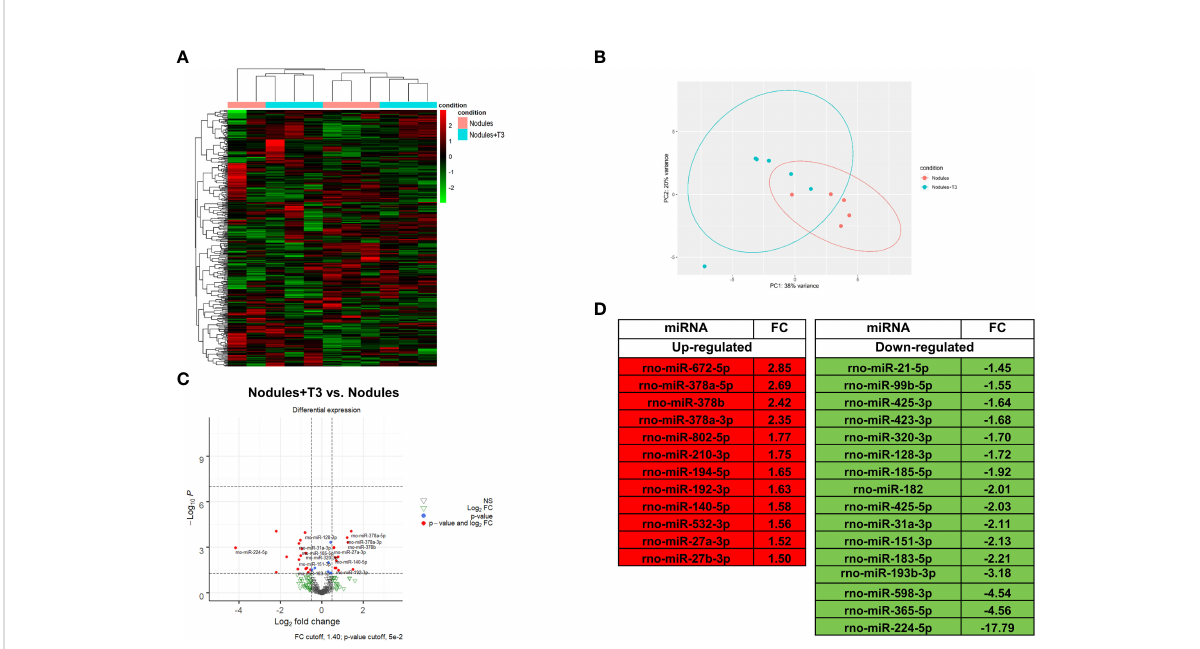
FIGURE 3 T3 modi fi es the global miRNA expression pro fi le of preneoplastic lesions (A) Hierarchical clustering of miRNA in preneoplastic lesions untreated (nodules) or treated with T3 for 4 days (nodules +T3). Each row represents the expression of a gene and each column a sample. Red and green colors represent higher or lower miRNA expression levels (median-centered), respectively; (B) Principal component analysis (PCA) indicative of the variability of miRNA expression data in nodules untreated or treated with T3 for 4 days; (C) Volcano plot of the 28 signi fi cantly differentially expressed miRNAs. Red dots indicate the miRNAs which qualify the P-value of 0.05 and Fold Change (FC) 1.4. Green and grey triangles indicate miRNAs which did not pass the P-value and Fold change cutoff respectively; (D) List of miRNAs differentially up- and down-regulated in nodules of rats fed T3 for 4 days vs . nodules of untreated